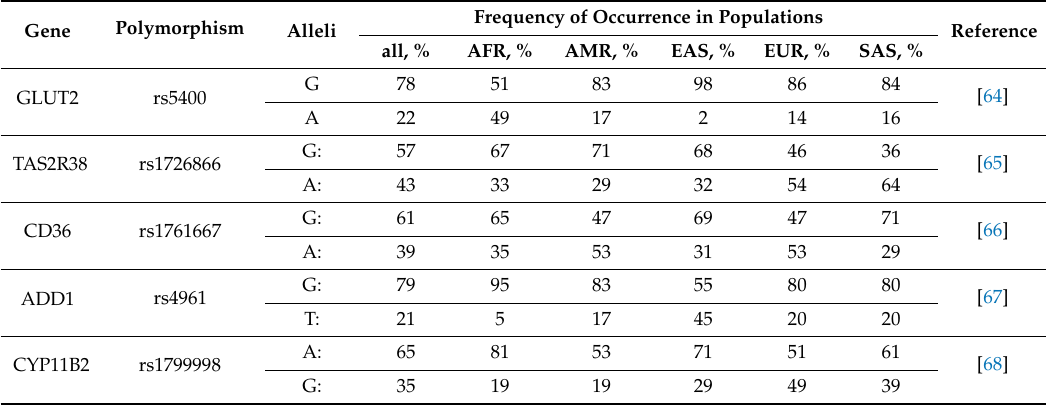
Table 4. Population genetics of genes responsible for taste